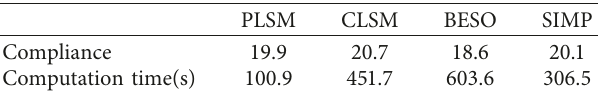
Figure 8: Iteration history of structural compliance for form finding of half-through arch bridge. Table 2: Comparison of results of different methods in form finding of half-through arch